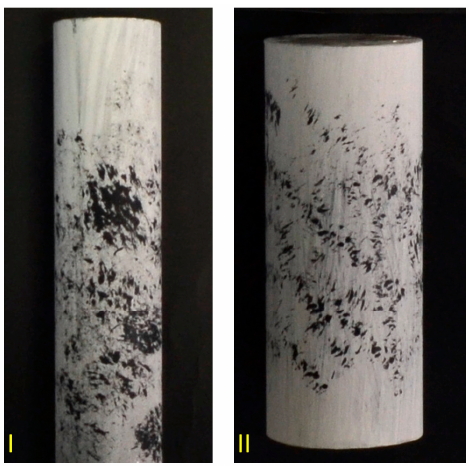
Figure 12. Metallic cylinders used for an additional set of experiments. ( I ) Cylinder with length 170 mm and diameter 31 mm; ( II ) Cylinder with length 126 mm and diameter 50 mm.